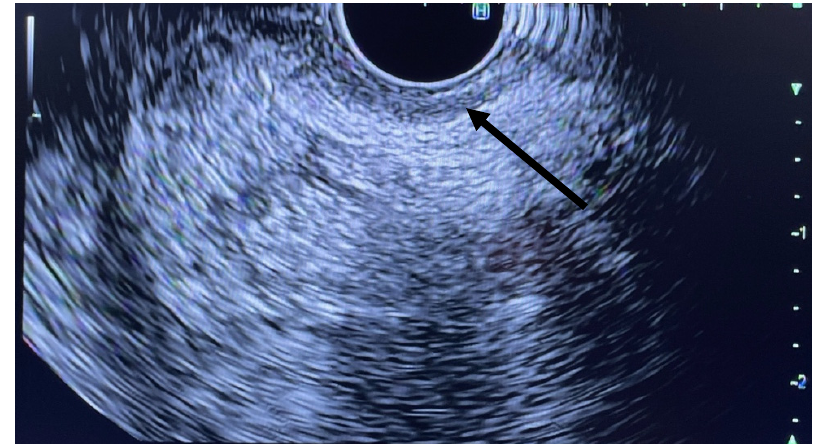
Figure 1. Radial EUS with arrow pointing to IAS.